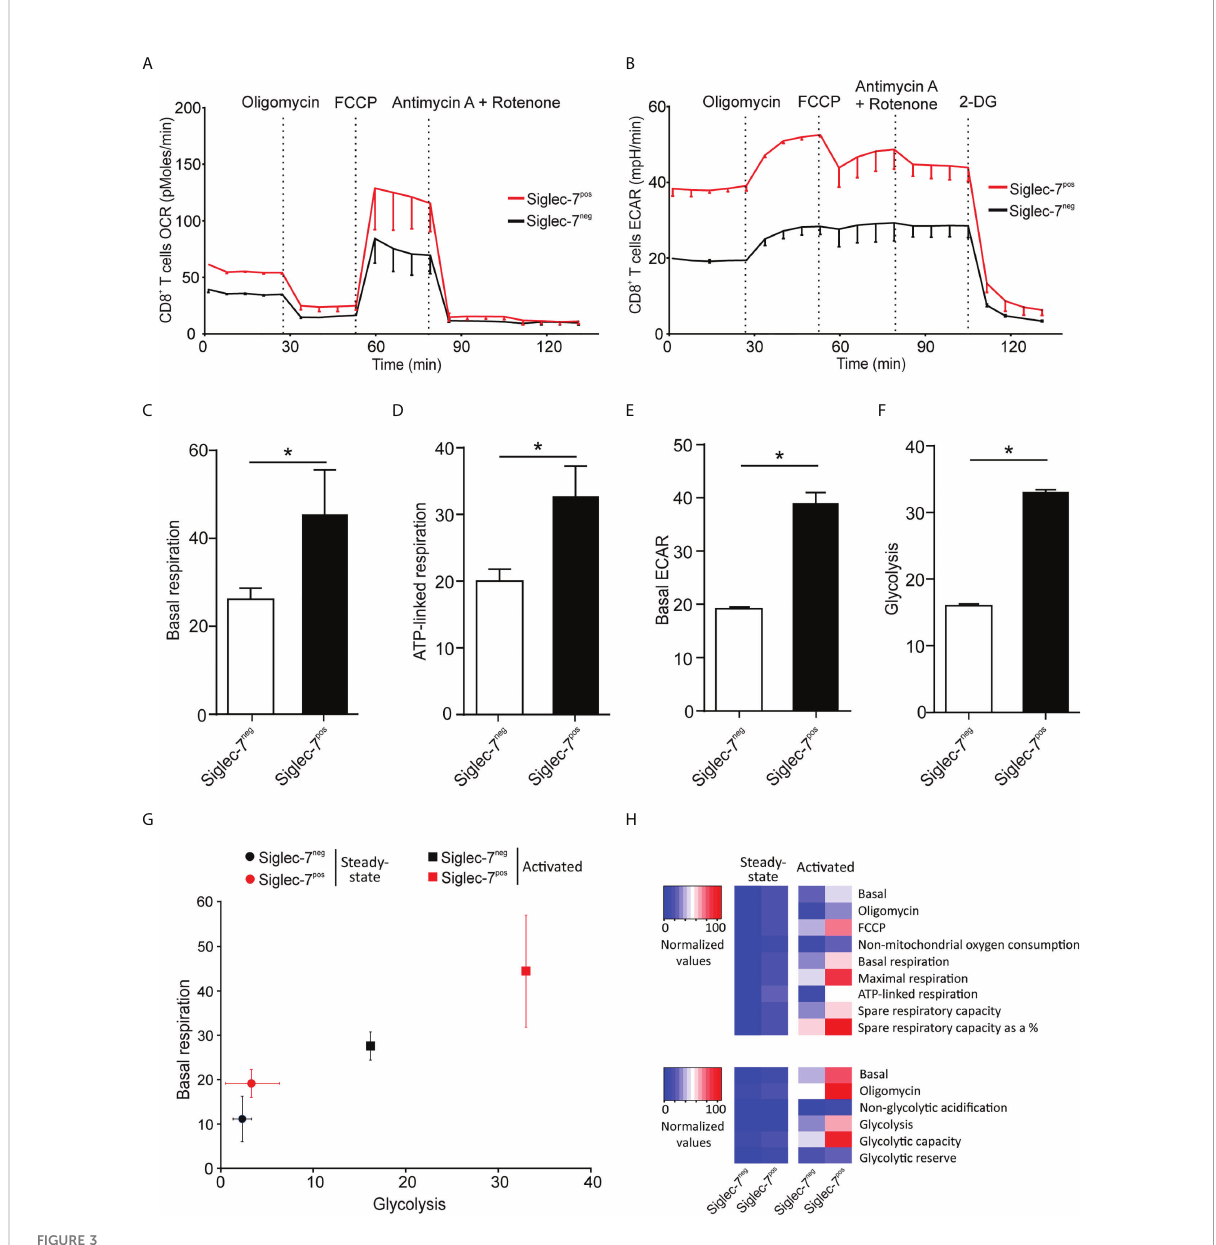
FIGURE 3 Upon activation Siglec-7 + CD8 + T cells exhibit a higher increase in oxidative phosphorylation and glycolysis compared to Siglec-7 - CD8 + T cells. Seahorse analysis of Siglec-7 + or Siglec-7 - CD8 + T cells after 7 days of co-stimulation by a CD3 and a CD28 (each at 1 m g/mL) (three independent experiments with 2-4 donors each, 11 donors in total). Oxygen consumption rate (OCR) (A) and extracellular acidi fi cation rate (ECAR) (B) pro fi les, basal respiration (steady state mitochondrial respiration) (C) , and ATP-linked respiration ( D OCR after oligomycin injection) (D) , basal acidi fi cation (ECAR at steady state) (E) , and glycolysis ( D ECAR at steady state minus non-glycolytic acidi fi cation in response to 2-DG injection) (F) . (G, H) Comparison of the metabolic pro fi les of a CD3 and a CD28 co-stimulated and unstimulated Siglec-7 + and Siglec-7 - CD8 + T cells. Plot representation of basal respiration and glycolysis rates (G) and heatmap representation (H) . Statistical analyses were performed by paired t test (C – F) . *P < 0.05. Error bars, SEM (A, B) or SD (C – G)